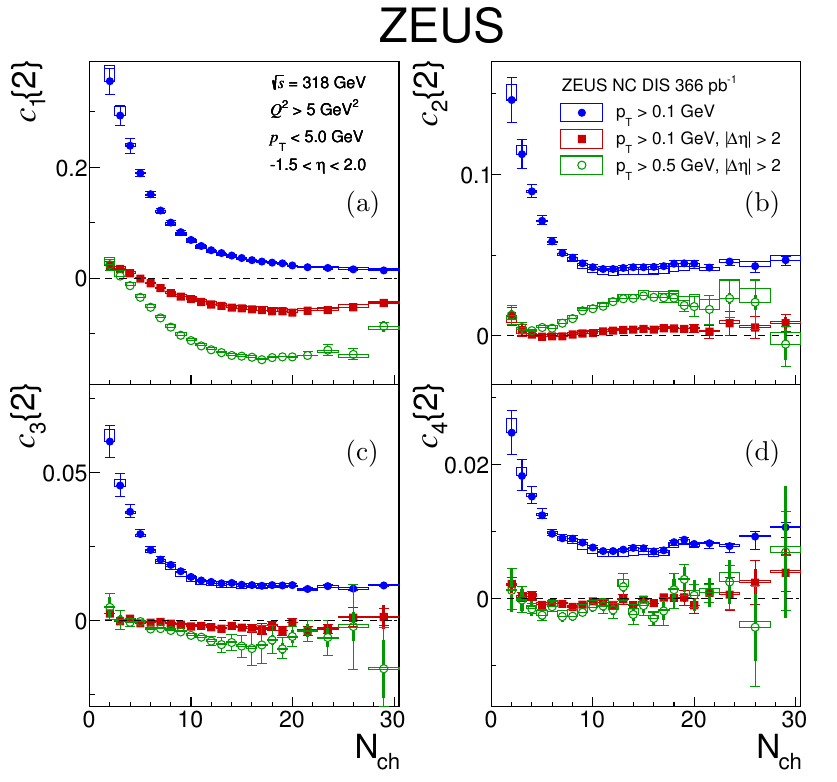
Figure 7 . Correlations c n f 2 g as a function of N ch for (a) n = 1, (b) n = 2, (c) n = 3, (d) n = 4, with and without a rapidity separation, and for low- and high- p T intervals. The statistical uncertainties are shown as thick vertical lines although they are typically smaller than the marker size. Systematic uncertainties from the Monte Carlo non-closure (see section 8) are shown as boxes. The other systematic uncertainties are shown as a thin vertical capped